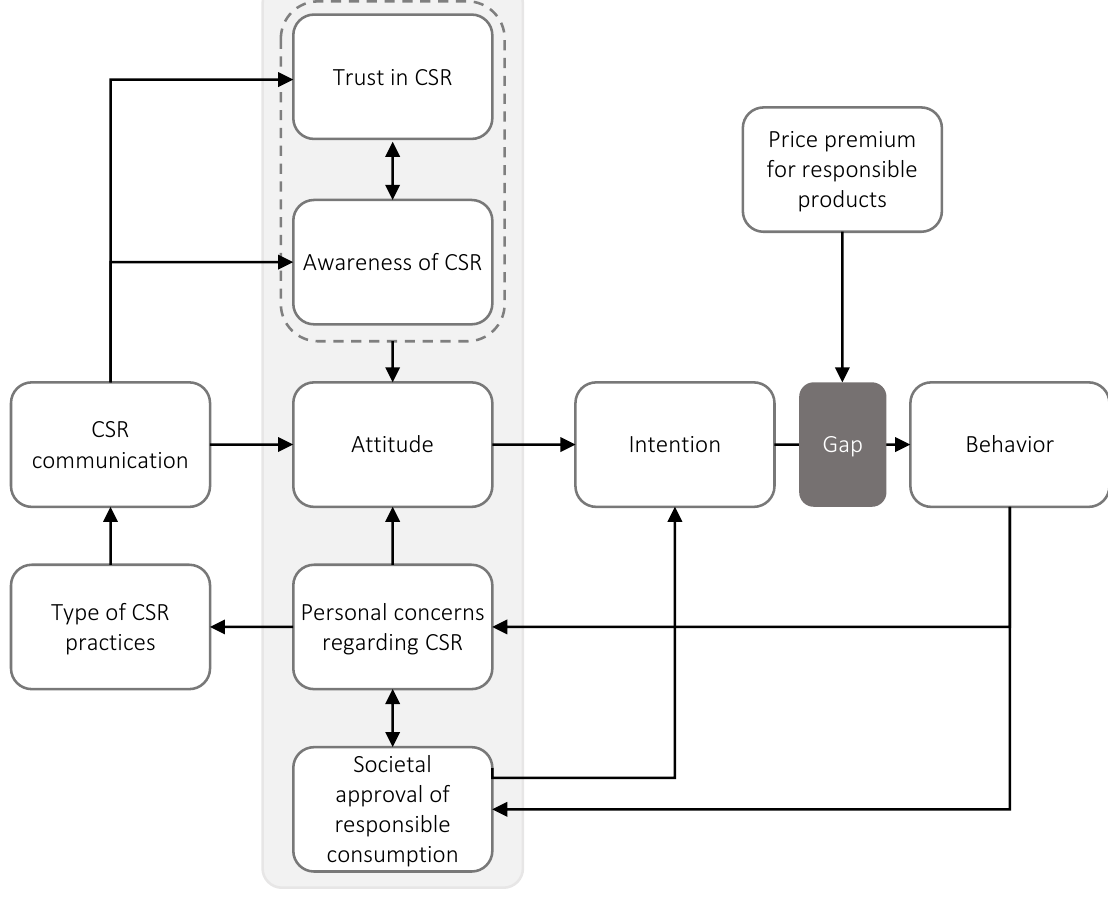
Figure 2. Conceptual research